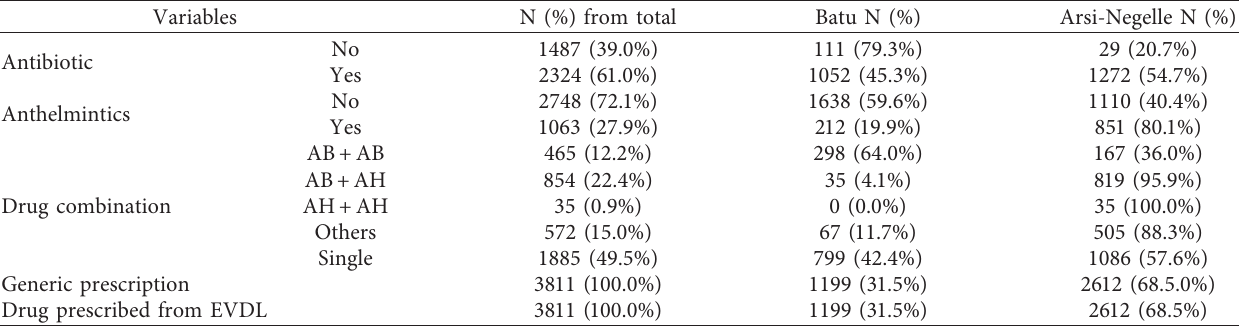
Table 2: Association between prescribed drugs and their combinations across the respective vet clinics.